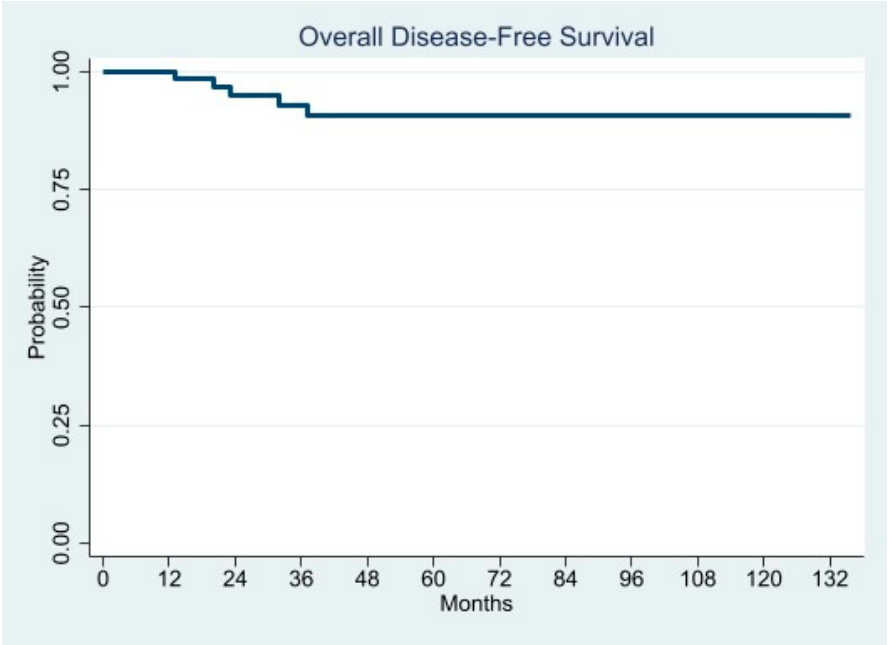
Figure 13. Overall Disease Free Survival.